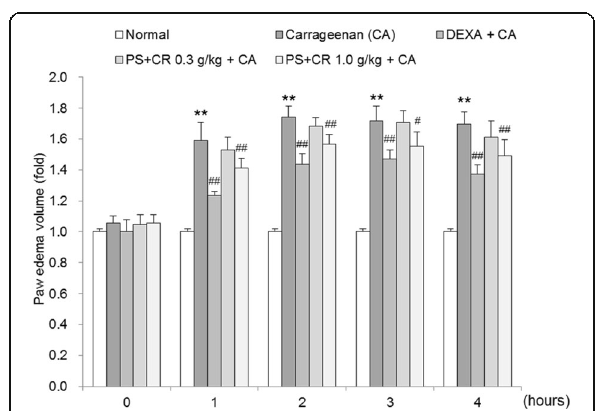
Fig. 6 Inhibition of carrageenan (CA)-induced paw edema by PS+CR. PS+CR was orally administered to rats at 0.3 or 1.0 g/kg/day for four days prior to the induction of paw edema. Paw edema was induced by subcutaneous injection of a 1% solution of CA dissolved in saline (0.1 ml per animal) into the right hind paw of each rat. The swelling volume of the paw was measured up to 4 h after the CA injection at intervals of 1 h using a plethysmometer. Dexamethasone (DEXA) (1 mg/kg, p.o.) was used as a positive control. Values represent the mean±S.D. of five animals (significant compared to the normal, ** p < 0.01; significant compared to CA alone, # p <0.05 or ## p